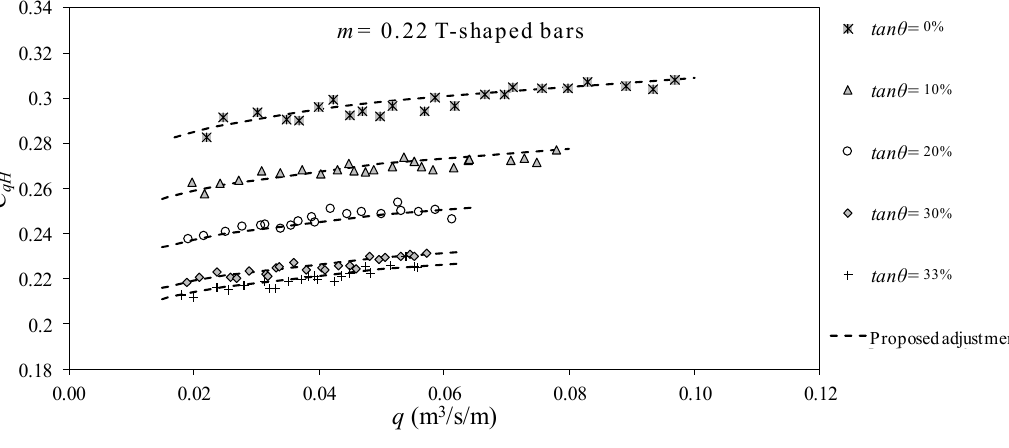
Figure 25. Mean discharge coefficient    as a function of the incoming flow q , for T-shaped flat bars with void ratio m = 0.28. An index of goodness of the adjustment IG may be considered. This parameter represents the sample standard deviation of the differences between measured and calculated values:  =  1    _ −  _